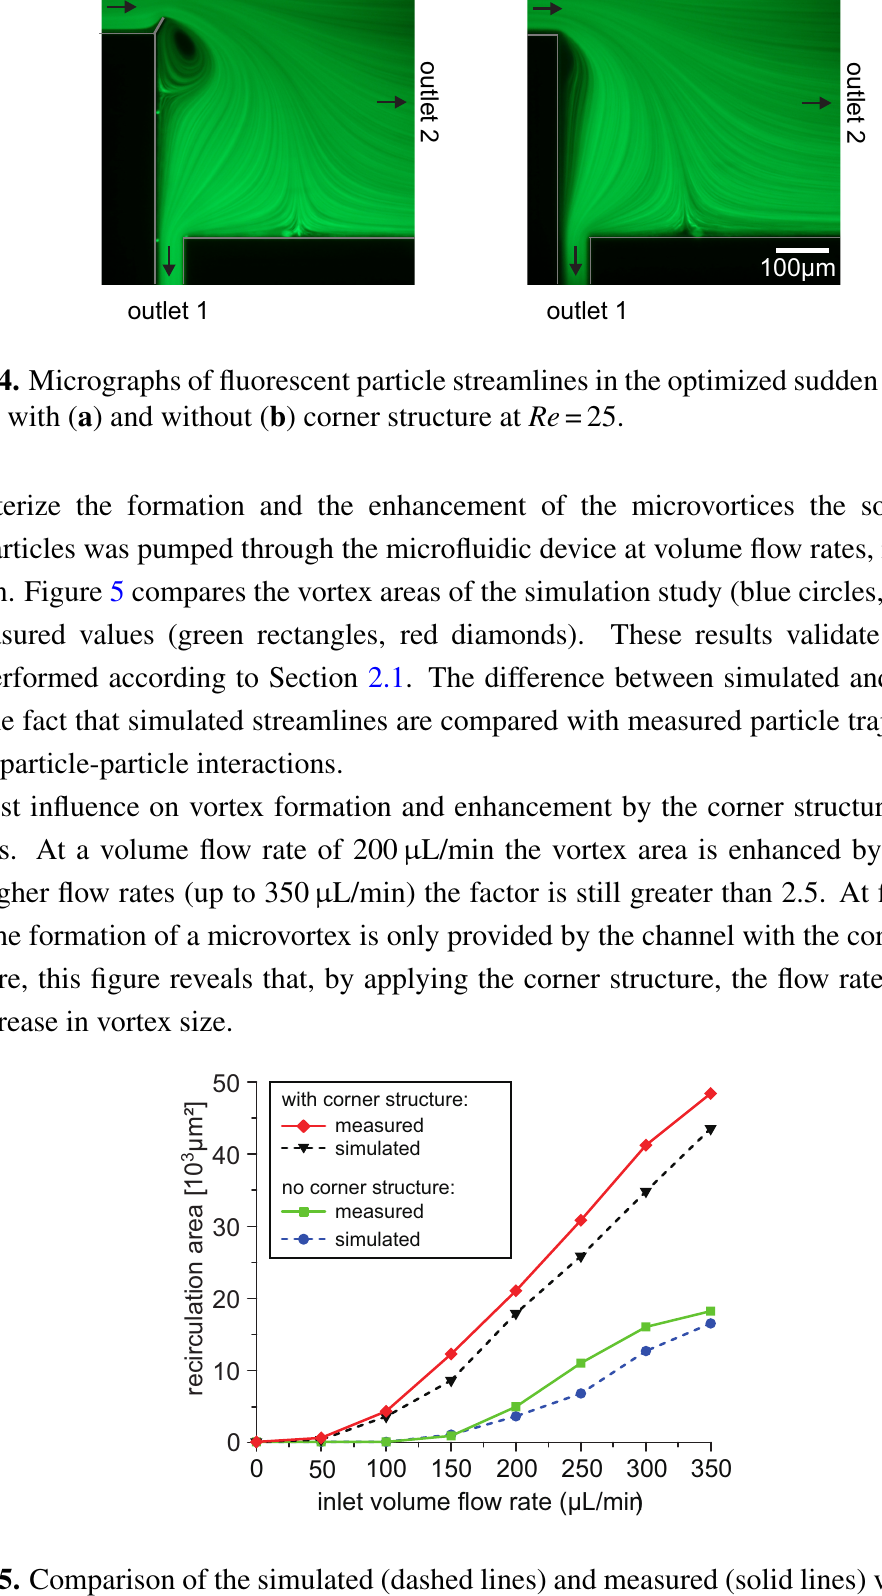
Figure 5. Comparison of the simulated (dashed lines) and measured (solid lines) vortex area in the sudden expansion channel with and without corner structure as a function of the inlet volume flow